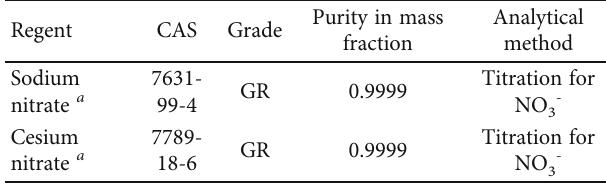
Table 1: Chemical reagents used in the experiment.